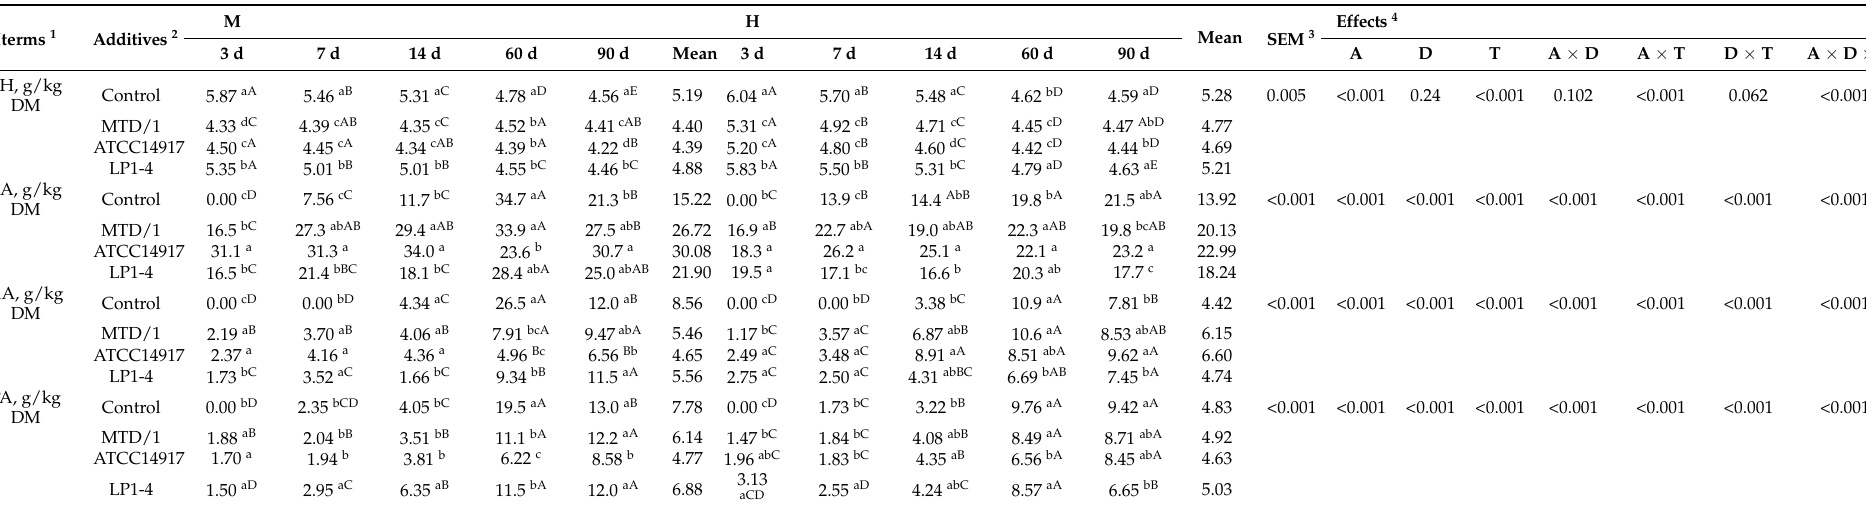
Table 2. Dynamics of fermentation characteristics of alfalfa silage ( n =